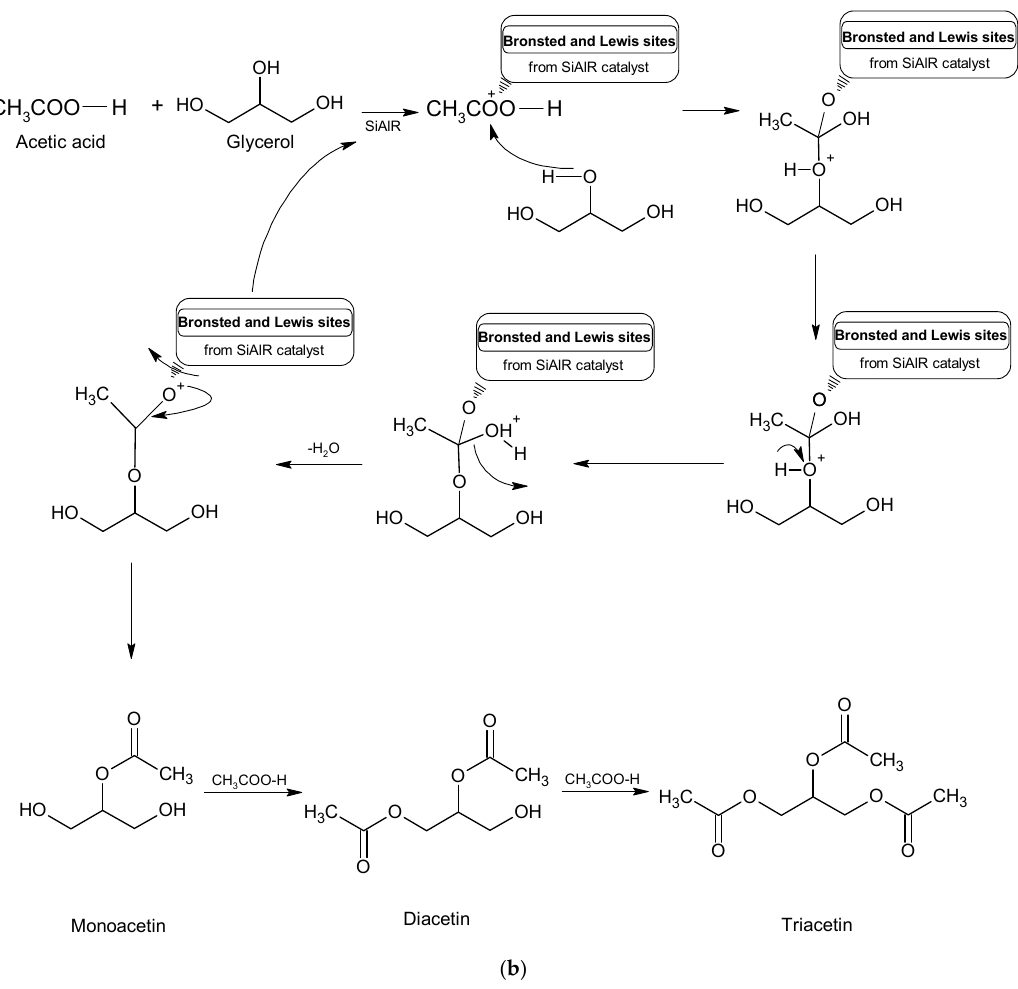
Figure 7. ( a ) The conversion of glycerol as function of the reaction time for SiAlA, SiAlR and SiAlR. The reaction conditions are: glycerol to acetic acid molar ratio of 1:3 and catalyst mass of 75 mg at 80 ° C; ( b ) Proposed reaction mechanism for glycerol esterification over SiAlR sample.